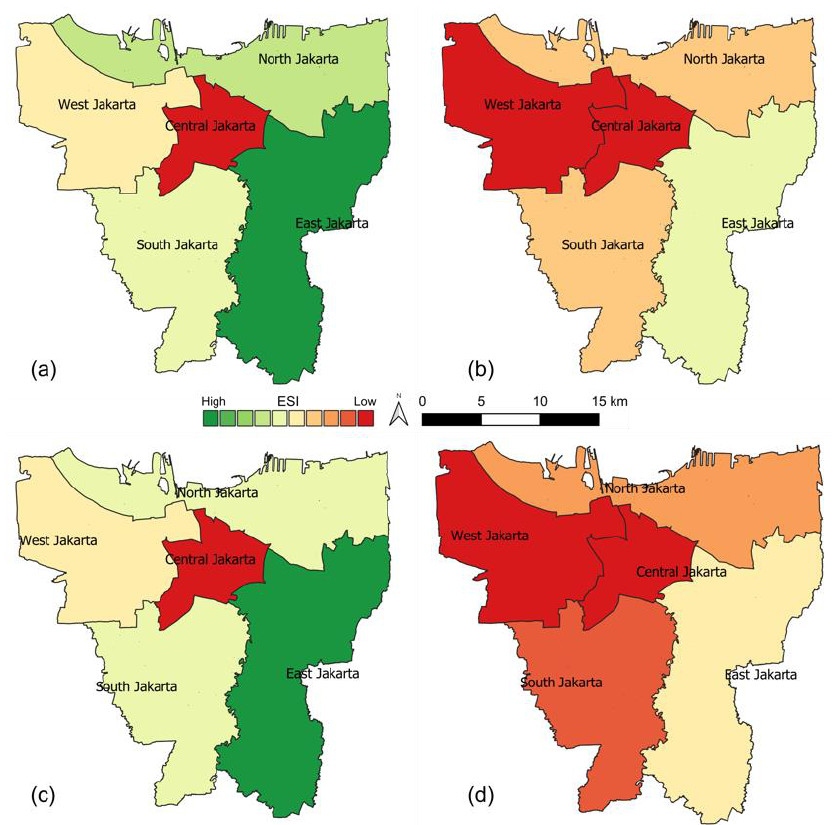
Figure 12. ESI for runoff regulation in the year 1995 and 2014. ( a ) ESI in 1995 without LMA; ( b ) ESI in 2014 without LMA; ( c ) ESI in 1995 with LMA; and ( d ) ESI in 2014 with LMA.